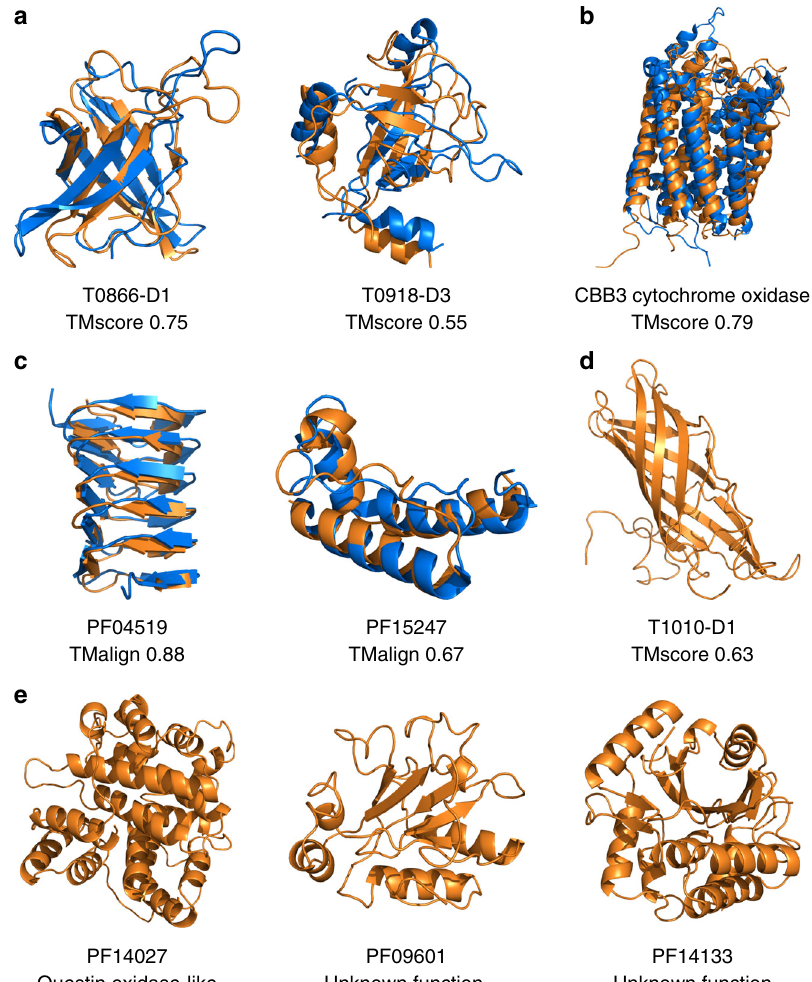
Fig. 1 Examples of DMPfold models. In each case the model is shown in orange and the native structure, if available, is shown in blue. a CASP12 FM domains. b A membrane protein from the FILM3 set. c Pfam families with available structures, used as a validation set. d CASP13 FM target T1010-D1, where DMPfold produced the best model at CASP13 (native structure not public). e Models displaying novel folds for Pfam families without structures